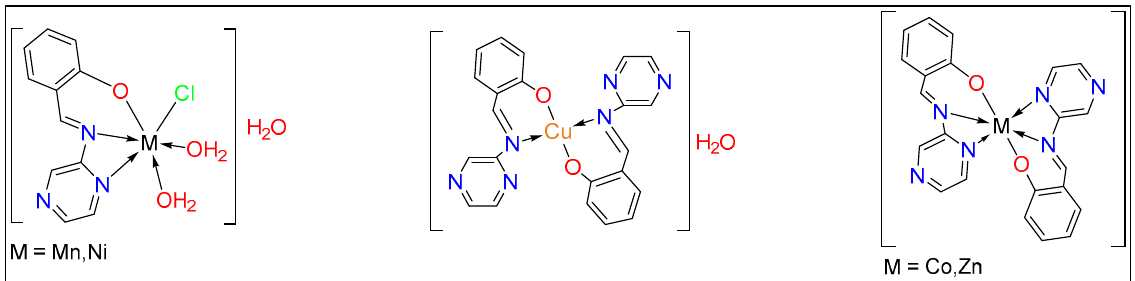
Figure 6. Suggested structure for metal complexes.